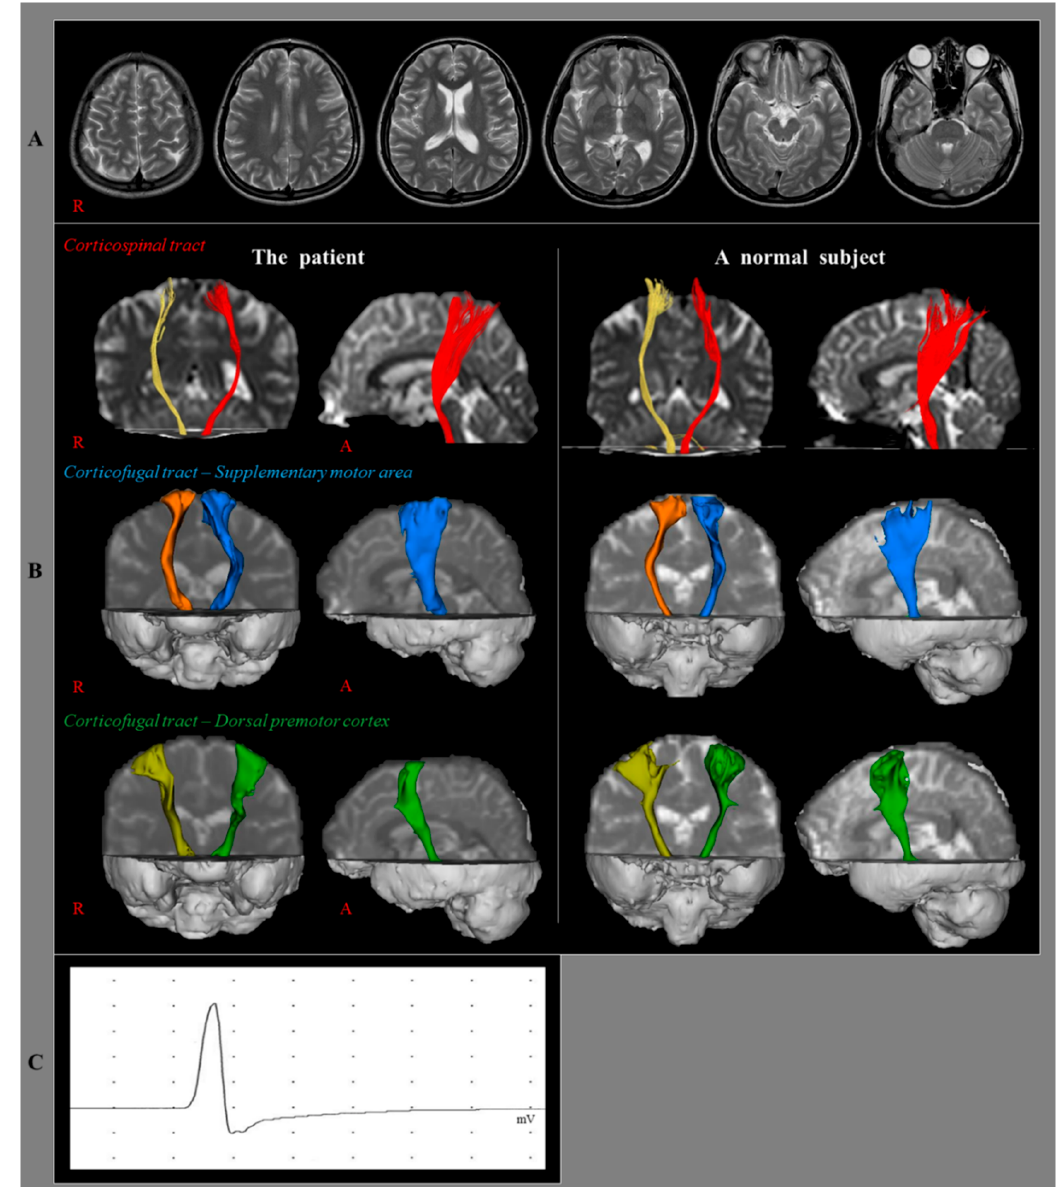
Figure 1. ( A ) Brain magnetic resonance imaging(MRI) images at 14 months after onset show no abnormal lesions. ( B ) Results of diffusion tensor tractography (DTT) for the corticospinal tract (CST) and corticofugal tract (CFT). On a 14-month DTT configuration, the left CST, CFT from supplementary motor area, and CFT from dorsal premotor cortex show similar configuration with a normal subject (24-year old female). ( C ) Results of transcranial magnetic stimulation (TMS). On a 14-month TMS study, motor evoked potential (MEP) is obtained at the right abductor pollicis brevis muscle during stimulation of the left hemisphere with 60% of maximal output (the MEP of shortest latency; 21.0 msec, amplitude: 5.1 mV).